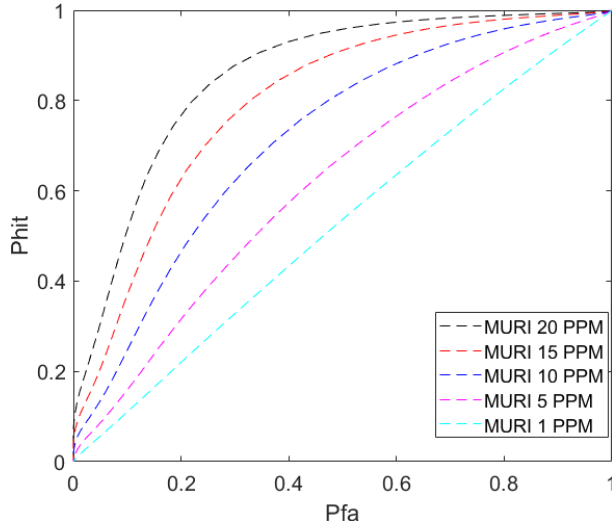
Figure 7. ROC curve describing the performance of applying the NDMI to the simulated data set using the methane feature band, band 1, and a relatively more transparent band, band 2 (see Table S2 for the area under each curve).